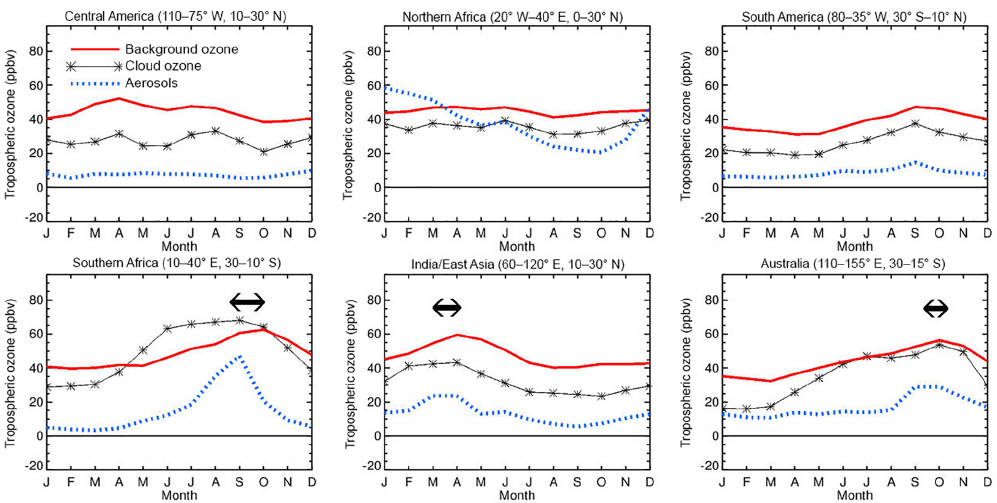
Figure 10. Twelve-month climatology time series for the six continental landmass regions plotted in Figs. 8 and 9 using the same color scheme. Shown here are background ozone (solid red curves), cloud ozone (asterisks), and aerosol index (dotted blue curves). The OMI aerosol index has been rescaled (i.e., multiplied by 60) for plotting. Approximate phase shifts between background ozone and aerosol index time series are shown with dark